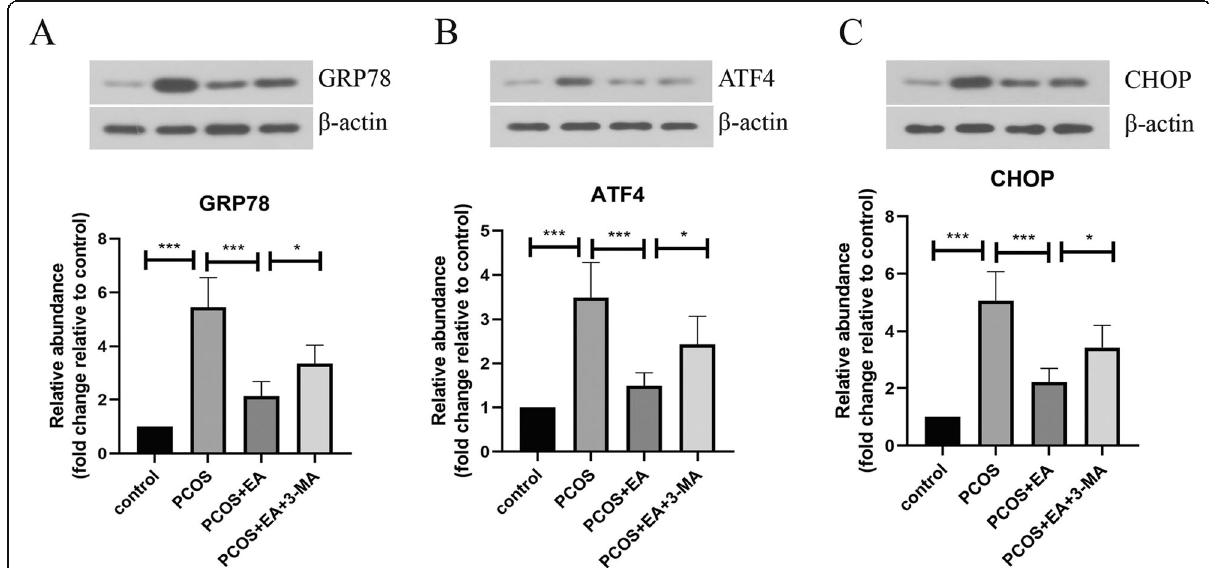
Fig. 6 EA attenuated ER stress in PCOS rats via promoting autophagy. a-c The protein levels of GRP78, ATF4, and CHOP in ovarian tissues were determined by Western blotting. The experimental data are presented as mean ± standard deviation (n = 6). * P < 0.05, *** P < 0.001, vs the indicated group. EA, electroacupuncture; PCOS, polycystic ovary syndrome; GRP78, glucose regulated protein 78; ATF4, activating transcription factor 4; CHOP, C/EBP-homologous